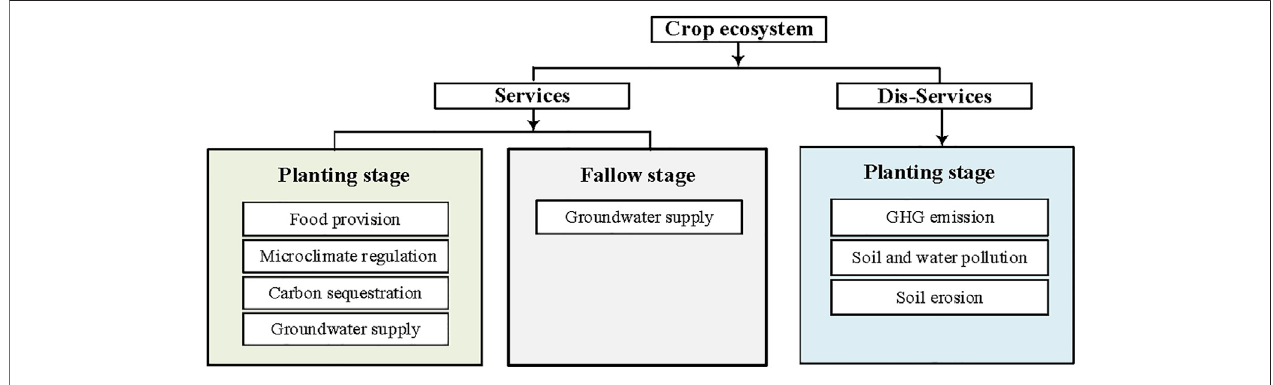
FIGURE 1 | The classi fi cation of agricultural ecosystem